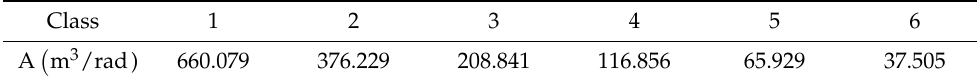
Table 3. Values of A proposed by FRA.